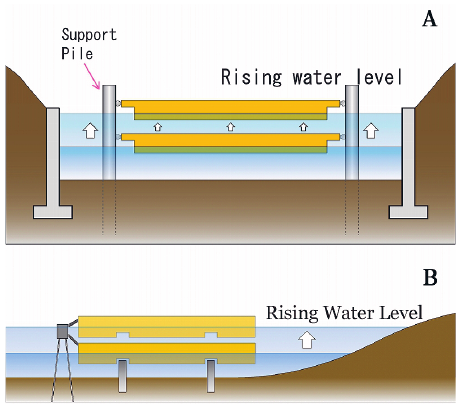
Figure 1. Floating platform with support